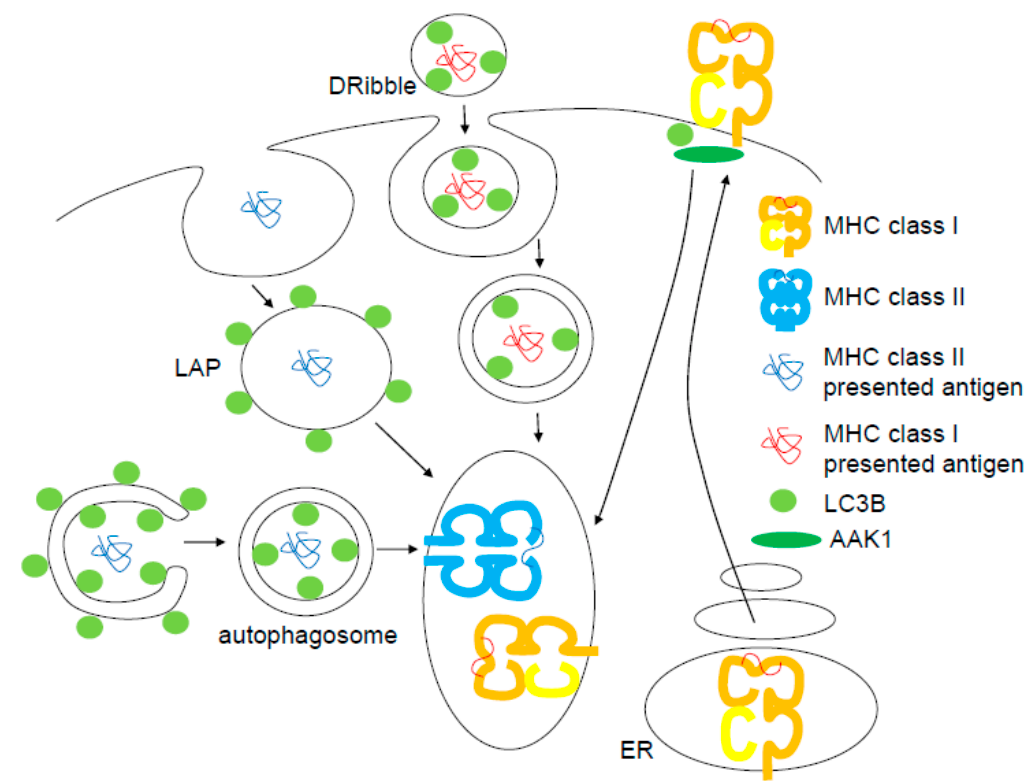
Figure 2. Atg8 orthologues regulate antigen presentation on MHC class I and II molecules. LC3B coated autophagosomes and phagosomes deliver intracellular and extracellular antigens for MHC class II presentation, respectively. LC3B positive DRibbles get processed for antigen presentation on MHC class I molecules and MHC class I molecules get internalized in an LC3B and adaptor associated kinase 1 (AAK1) dependent fashion.